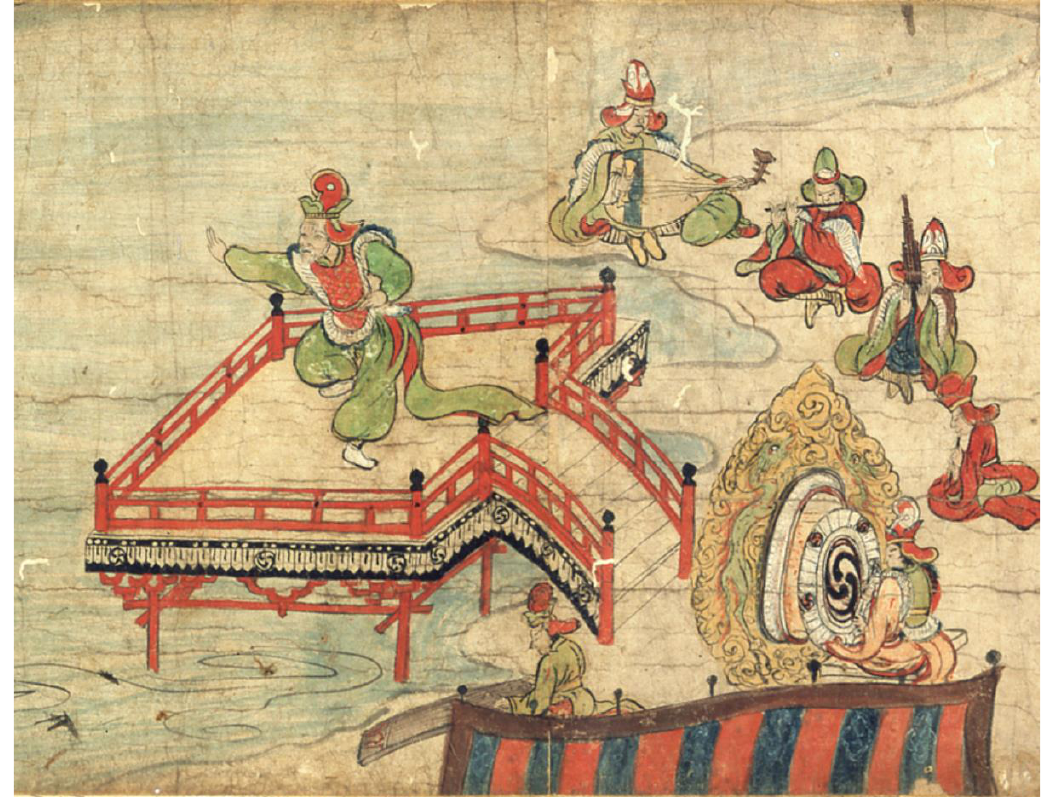
Figure 1. Hachiman Daibosatsu goengi 八幡大菩薩御縁起 (The August Story of the Great Bodhisattva